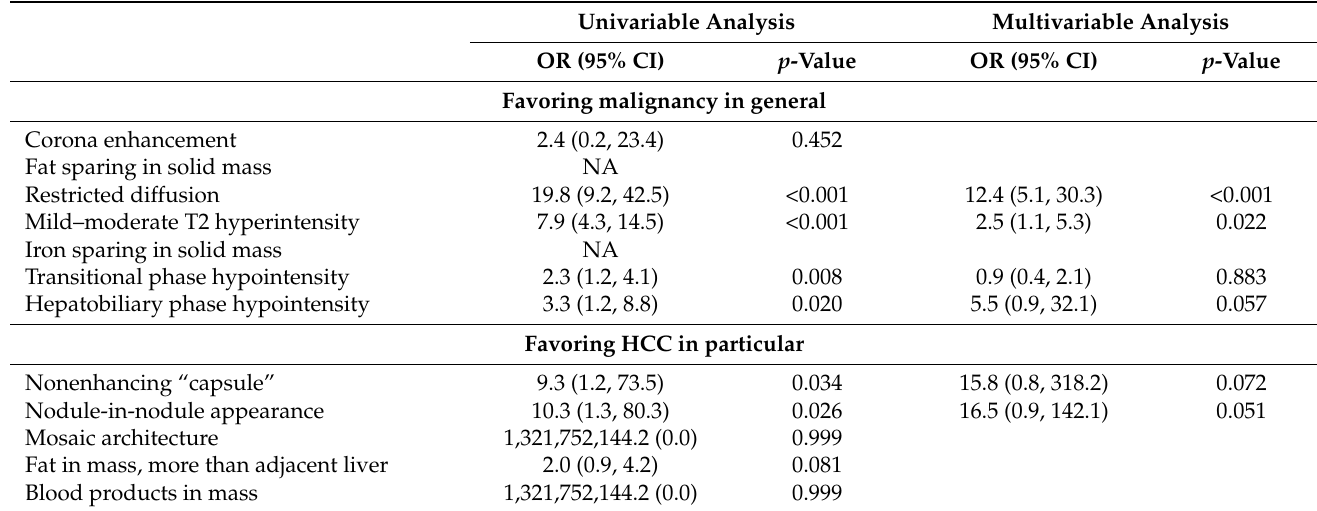
Table 3. Univariable and multivariable analysis of AFs associated with HCC.